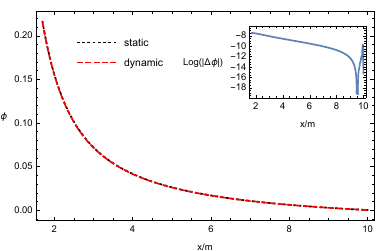
Figure 7 . The spatial profile of the scalar field φ , as a function of x/m , for the static HBH solution, compared against that as the final state resulting from the dynamic scalarization process. The inset gives the difference ∆ φ